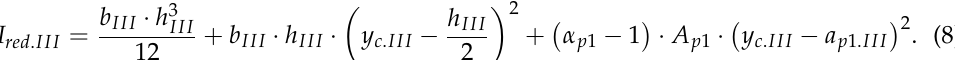
Figure 12. Analysed cross-section III-III.